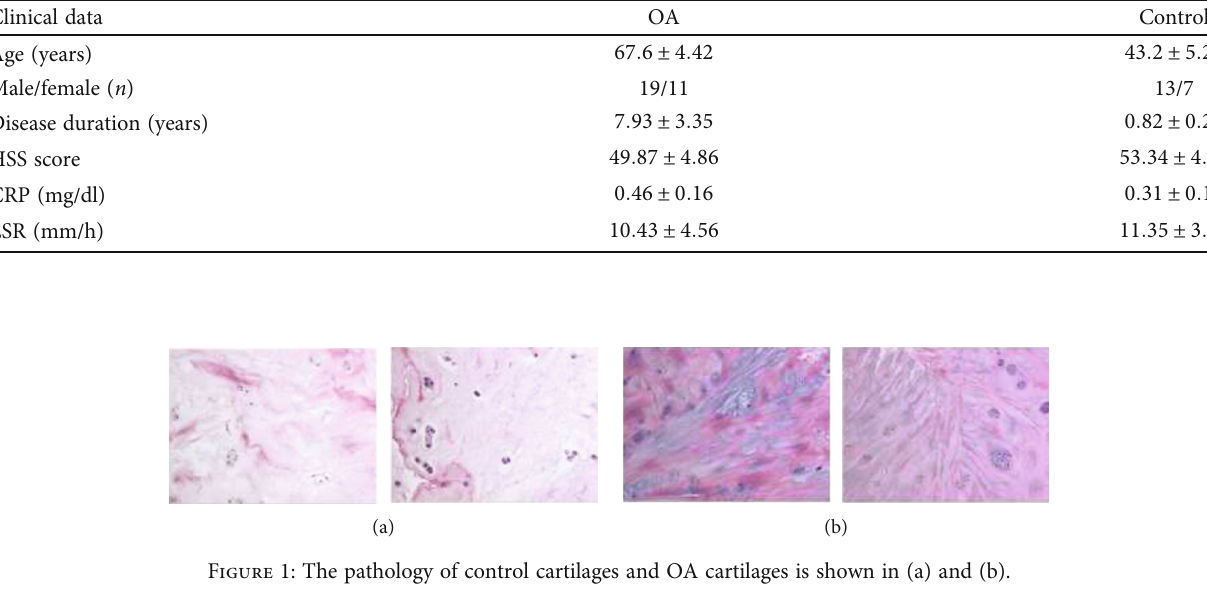
Table 1: Clinical and demographic characteristics of the study OA and control population.